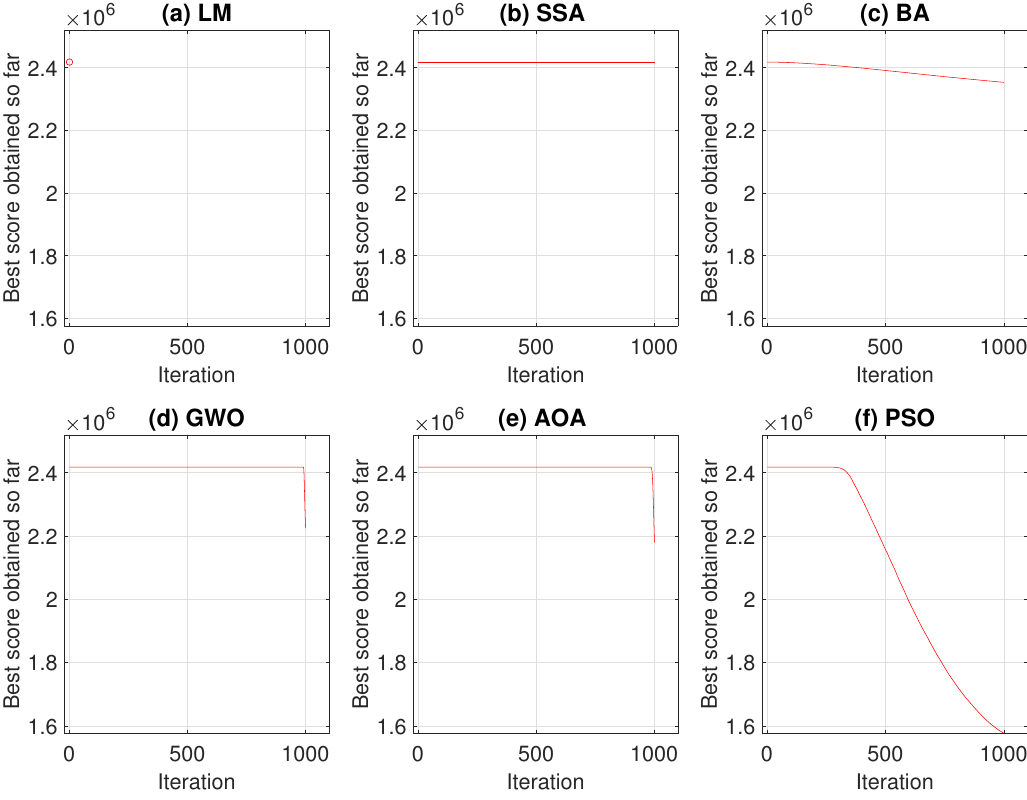
Figure 13. Average Convergence